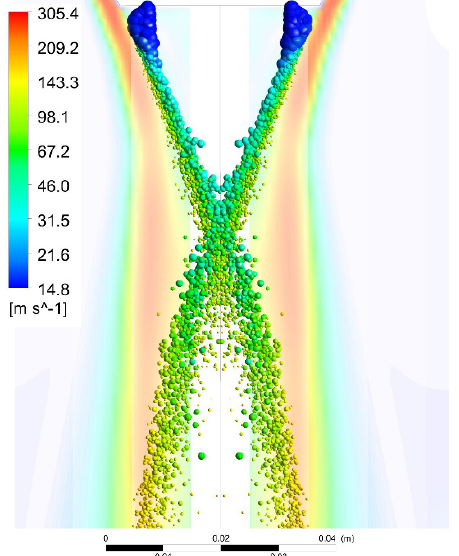
Figure 10. Partial enlarged view of droplet convergence area.